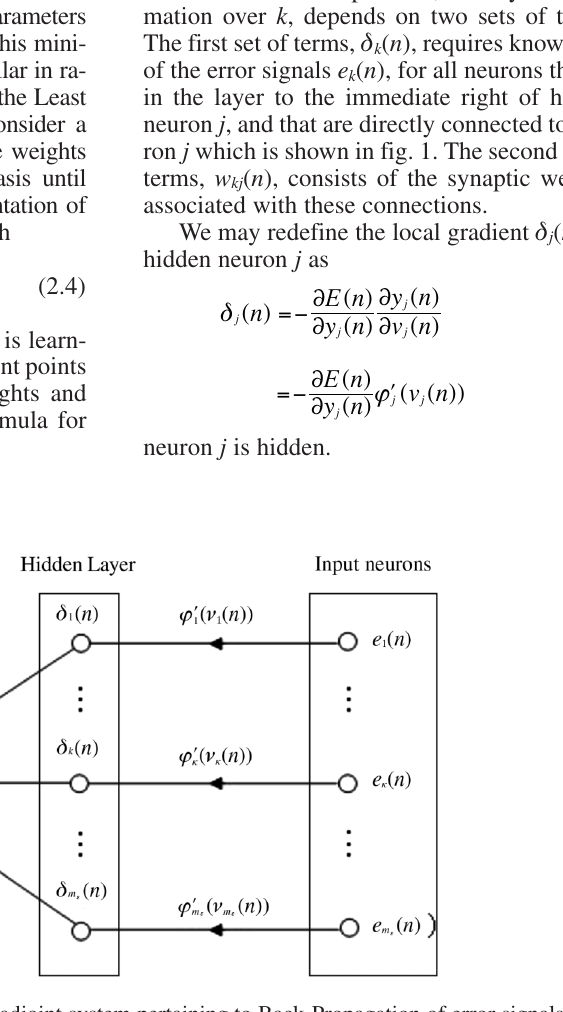
Fig. 1. Signal flow graph of a part of the adjoint system pertaining to Back-Propagation of error